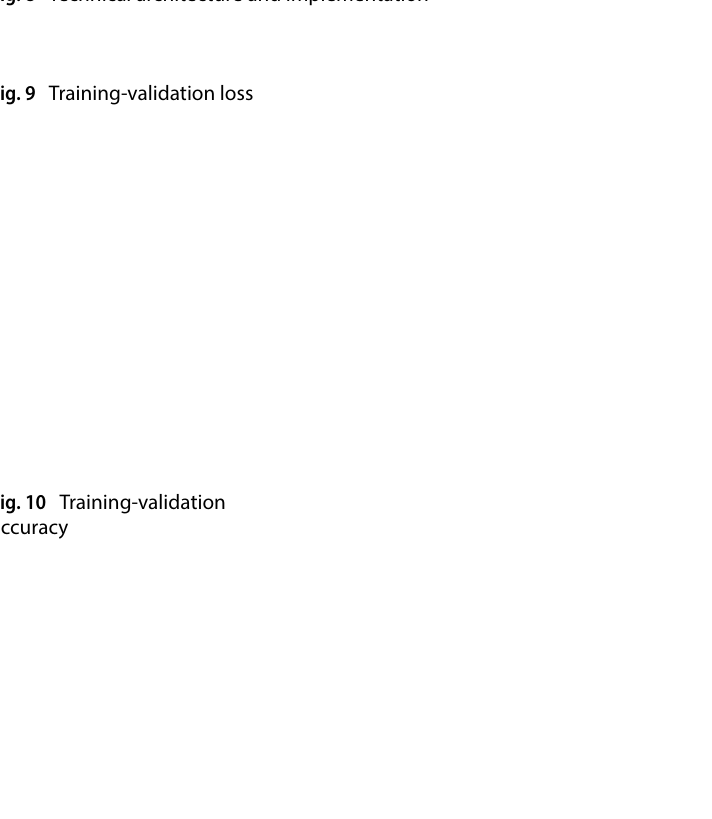
Fig. 8 Technical architecture and implementation